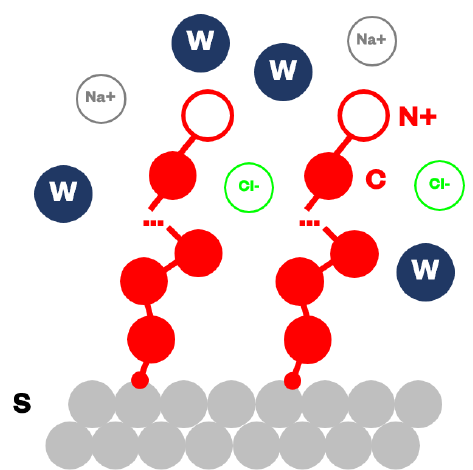
Figure 1. Coarse-grained representation of water, grafted alkylamines, PEG/PEI surface, and Na+ and Cl − ions.